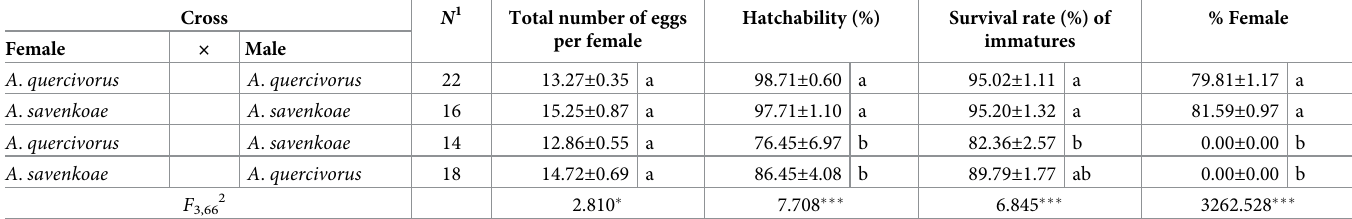
Table 3. Number of eggs laid during the first five days of the oviposition period, egg hatchability, survival rate of immature stages and sex ratio of F1 progeny from crosses between Amphitetranychus quercivorus (Tsukuba) and A . savenkoae (Kherson) at 25˚C under a 16:8 h light:dark photoperiod. Cross